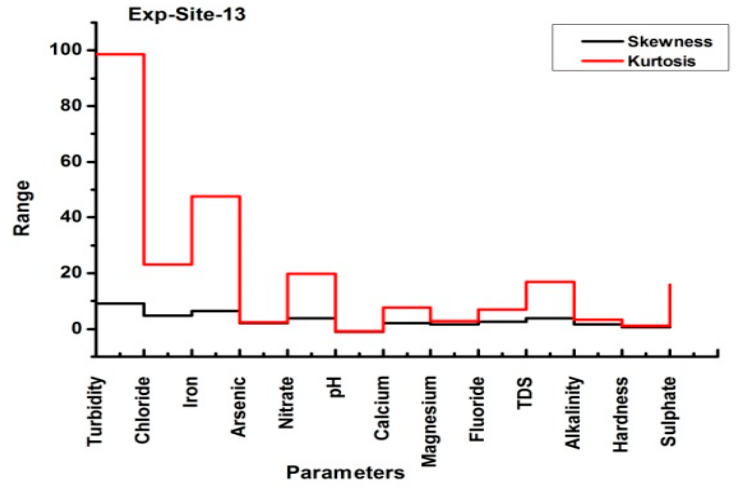
Figure 7. Kurtosis and skewness curve for each (13) parameters over 13 experimental site.